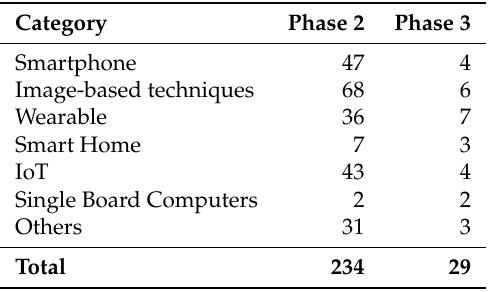
Table 1. Papers classification in phase 2 and phase